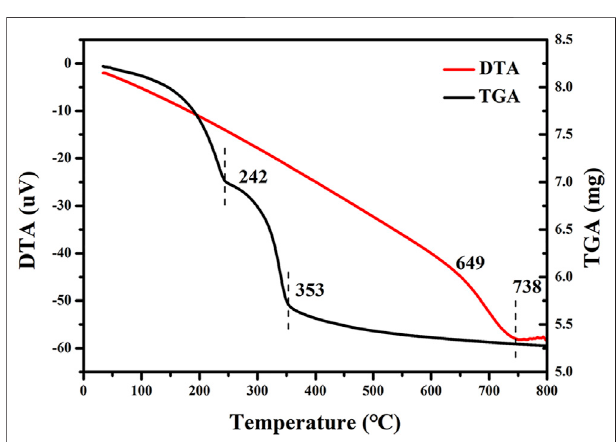
FIGURE 6 | TG-DTA curves for CuCoNiAl-LDH in N 2 . The heating rate was 10 ° C/min.